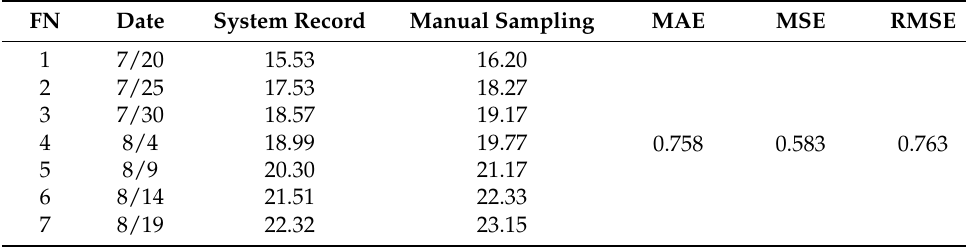
Table 6. Comparison of the results of plant height